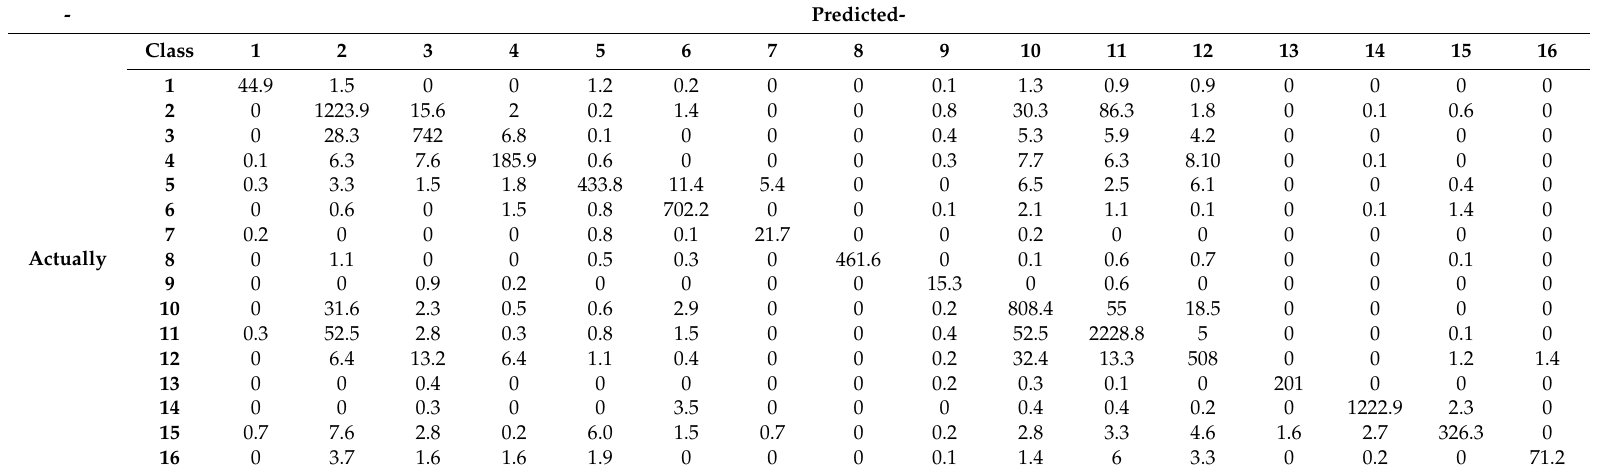
Table A1. The confusion matrix of the proposed ESMLR with linear MFL from the Indian Pines dataset corresponding to Table 1.